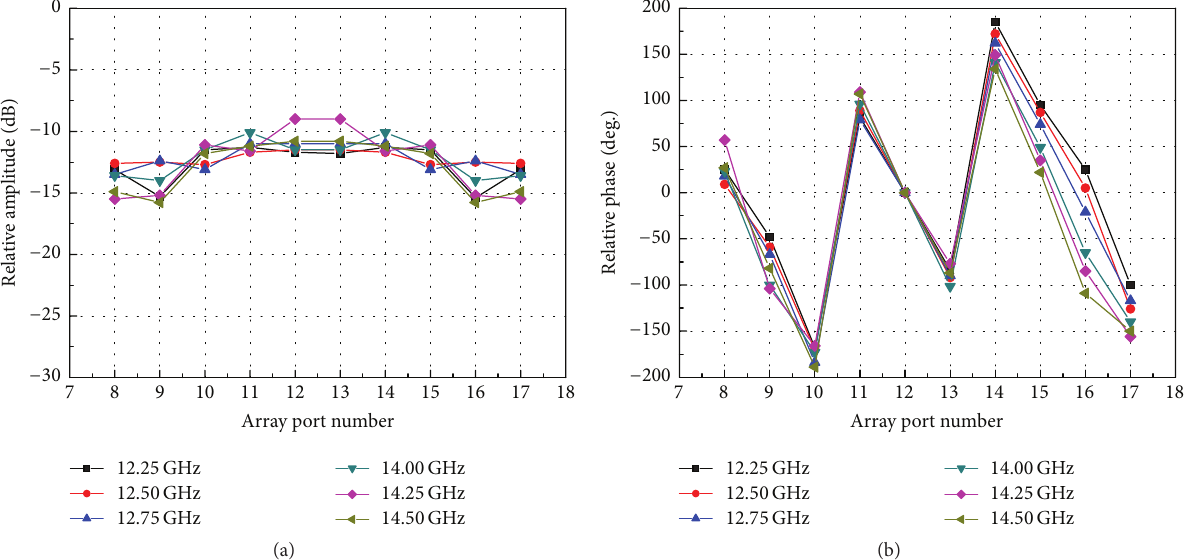
Figure 9: (a) Array ports relative amplitude distribution excited by edge port 1. (b) Array ports relative phase distribution excited by edge port